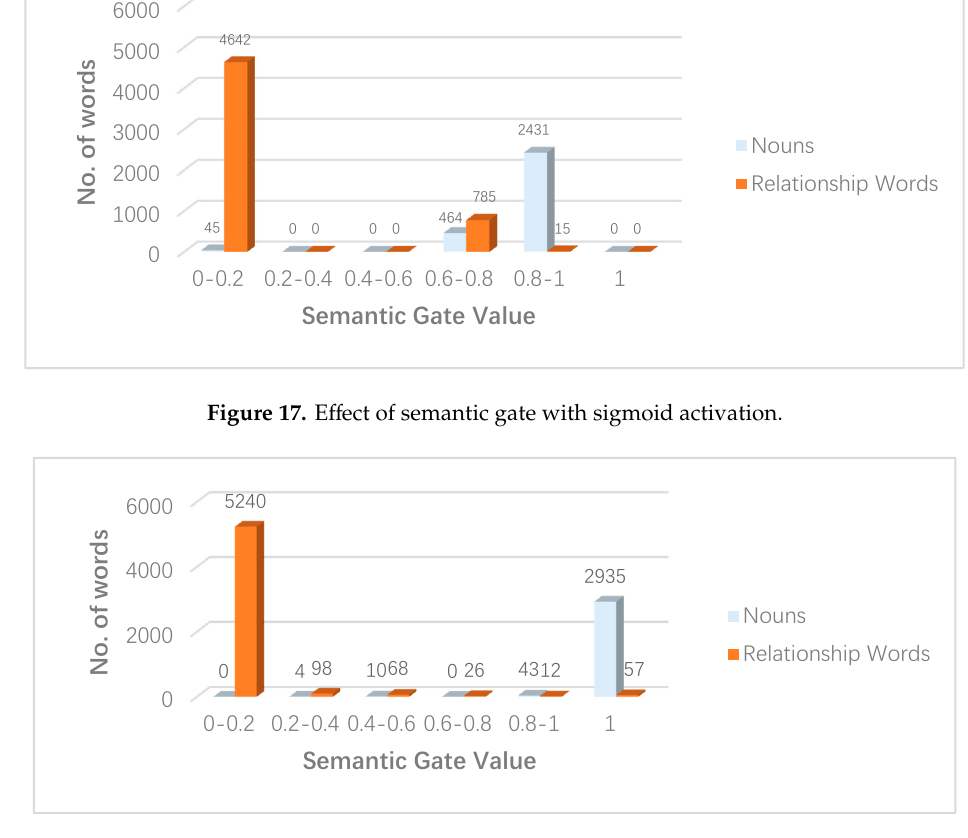
Figure 18. Effect of semantic gate with customized activation. Figure 18. E ff ect of semantic gate with customized activation.